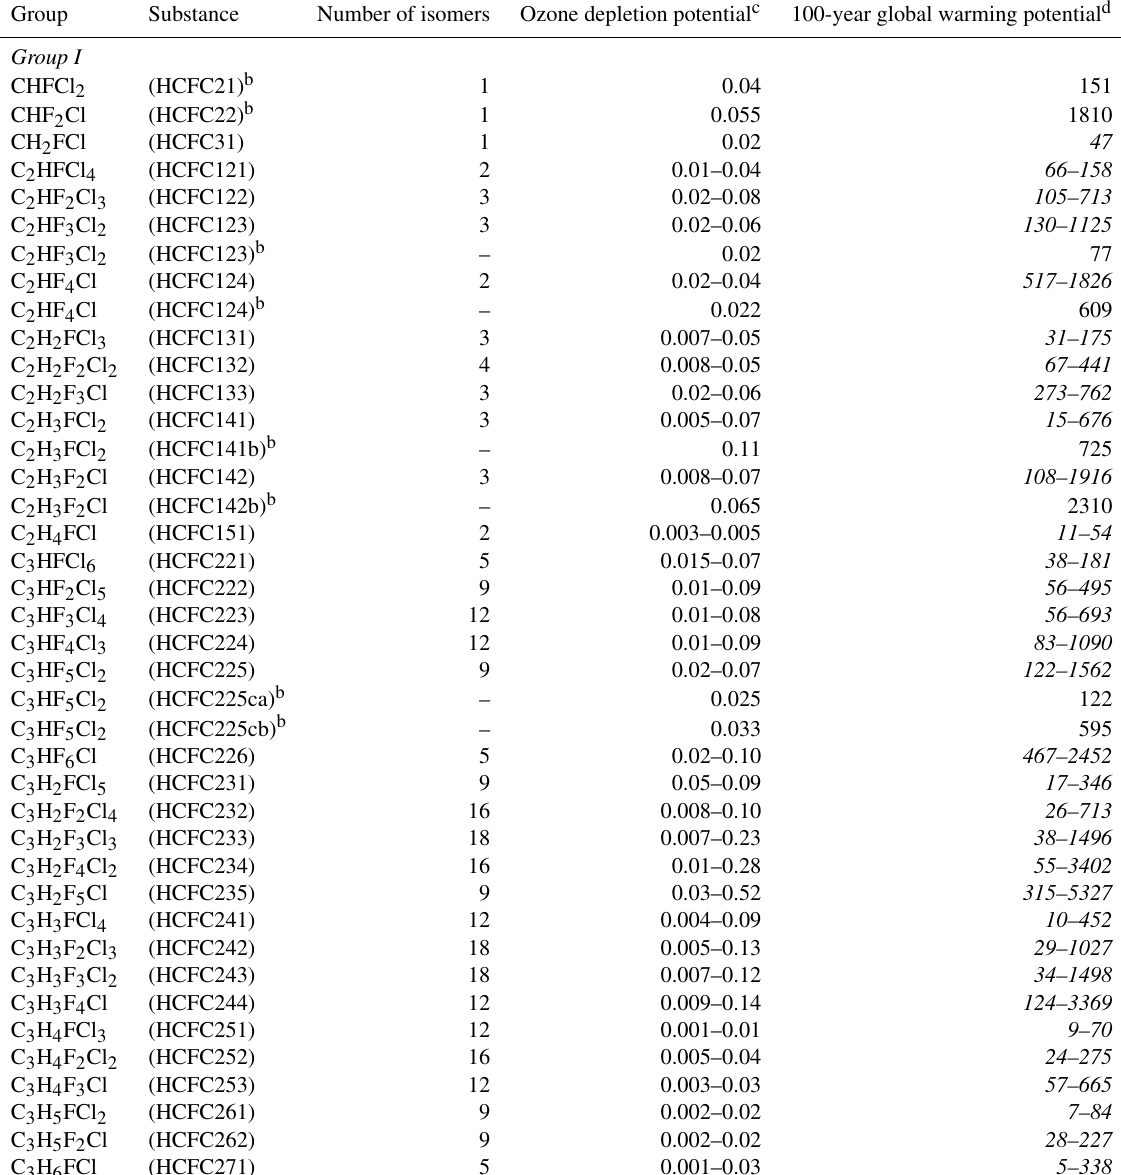
Table 2. The Annex C HCFC table provided in the Kigali Amendment to the Montreal Protocol, where the range of 100-year time horizon global warming potentials (GWPs) obtained in this work for various HCFC isomers all with the chemical formula listed in the first column is given in italics a